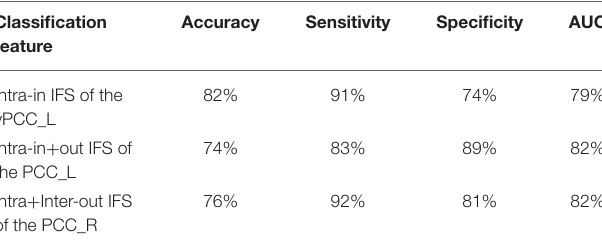
TABLE 3 | Classification performance using linear SVM classifiers with the regional IFS of ROIs within DN as classification features. Classification